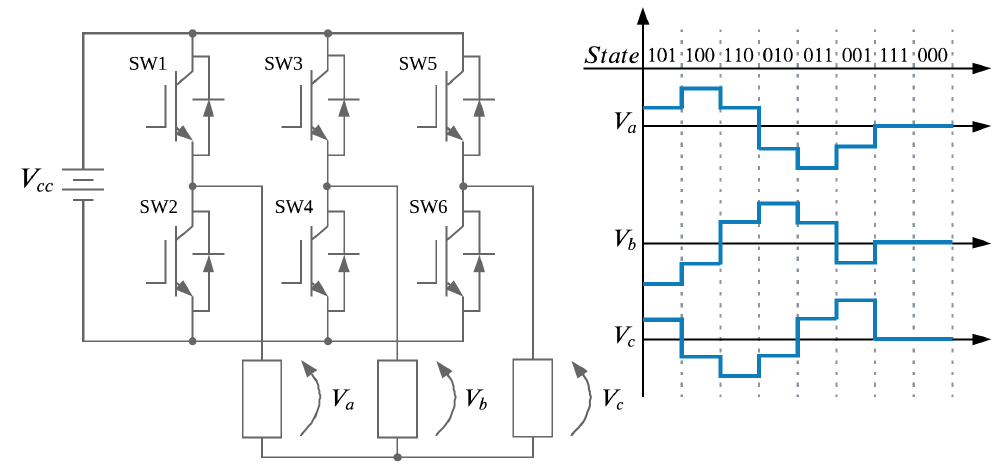
Figure 14. Single-phase voltage combinations for a two-level three-phase converter. Each of the six nonzero states gives rise to a vector in the complex plane αβ (Figure 15). The six active vectors have magnitude 2 V cc /3 and lagged from each other by an angle of 60 ◦ . The null vectors are represented at the origin of the complex